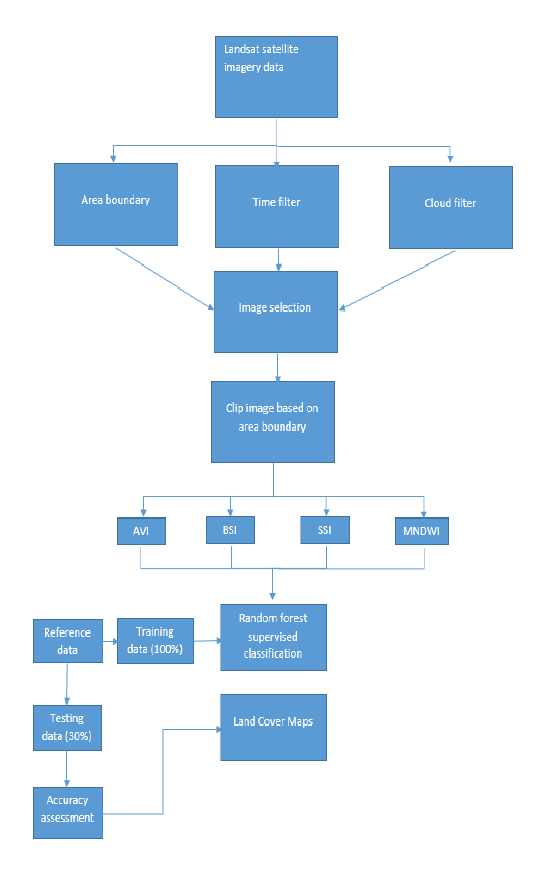
Figure 7: Descriptive workflow on GEE